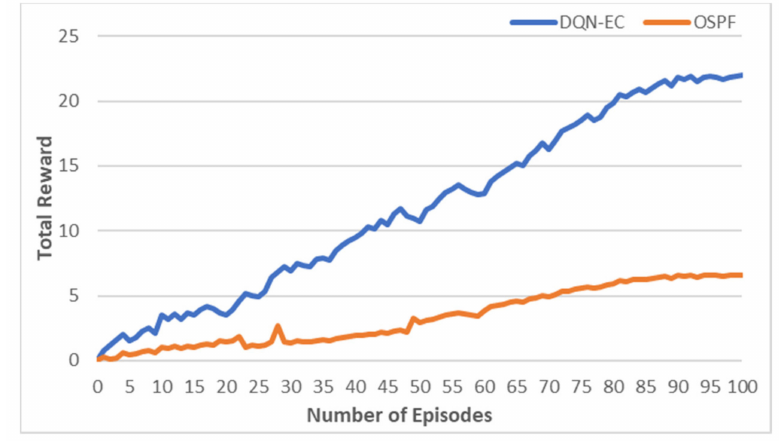
Figure 8. Total reward based on number of episodes.